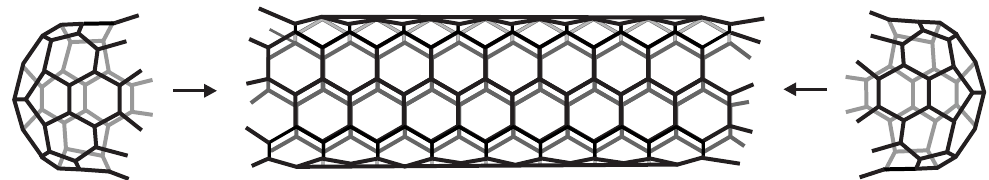
Figure 3. Construction of a nanotubical fullerene graph with two